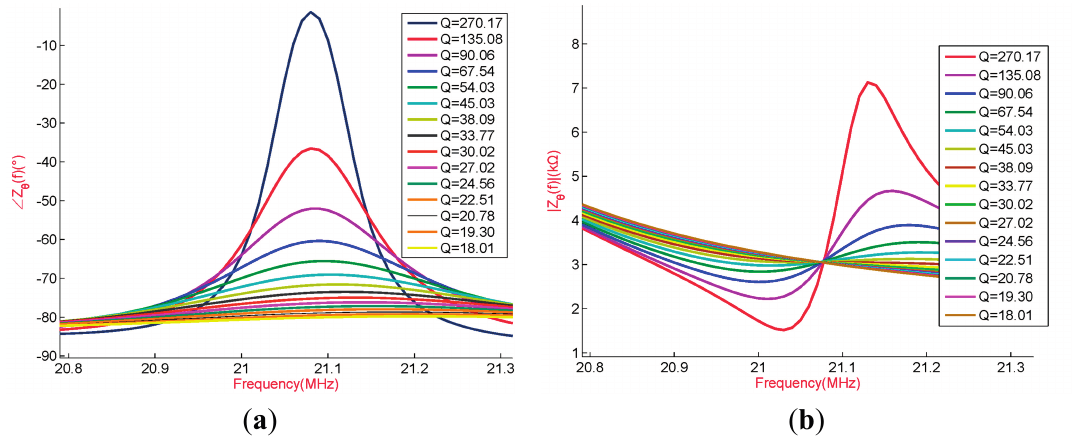
Figure 4. ( a ) Antenna coil phase of input impedance for the quality factor variation; ( b ) Antenna coil Magnitude of input impedance for the quality factor variation.